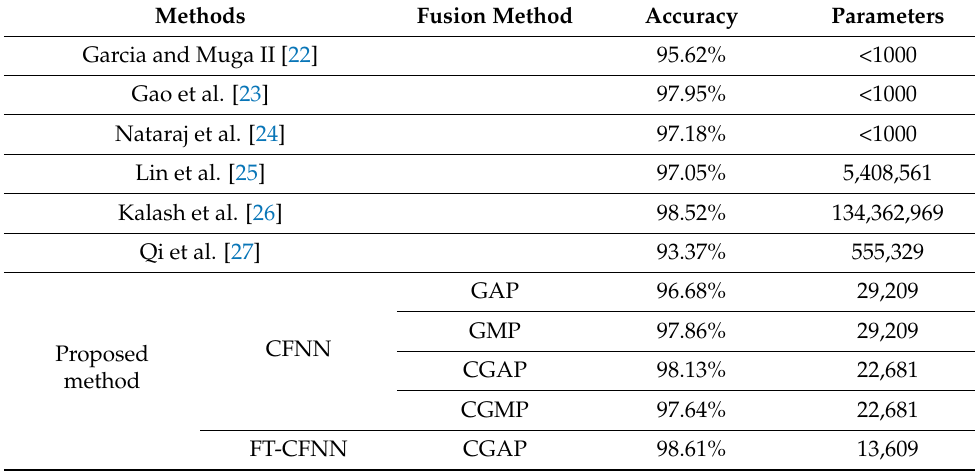
Table 11. Accuracy values obtained by various methods and the number of parameters required by these